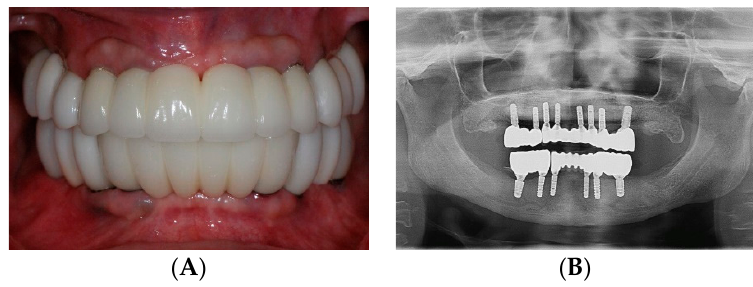
Figure 8. Definitive prosthesis. ( A ) Intraoral view. ( B ) Panoramic radiograph.